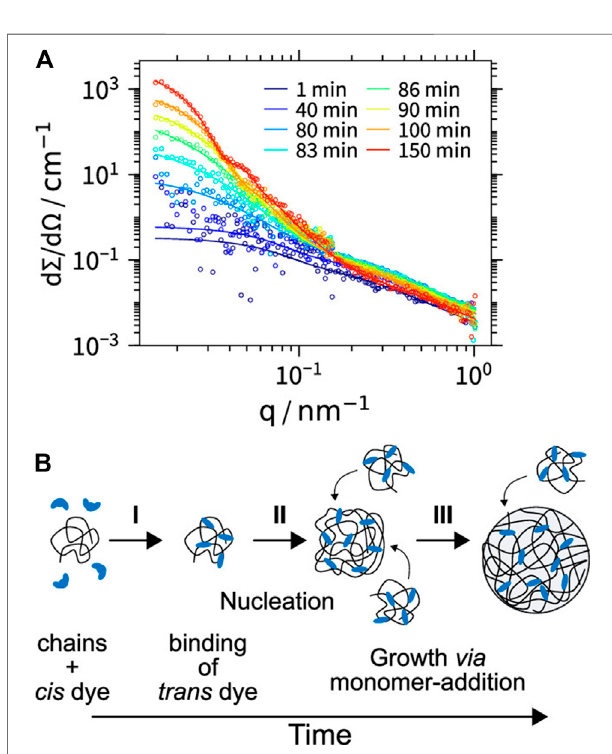
FIGURE 22 | Study of the formation mechanism in light-responsive electrostatic self-assembly: (A) Selected SANS pro fi les of reforming PA – diAzoEt complexes after irradiation and reassembly at 45 ° C. The solid lines represent fi ts to the model of a mixture of free polymer chains and complexes; (B) Illustration of the mechanism of the self-assembly of the PA − diAzoEt complexes (Carl et al., 2020). Reprinted with permission. Copyright © 2019 American Chemical